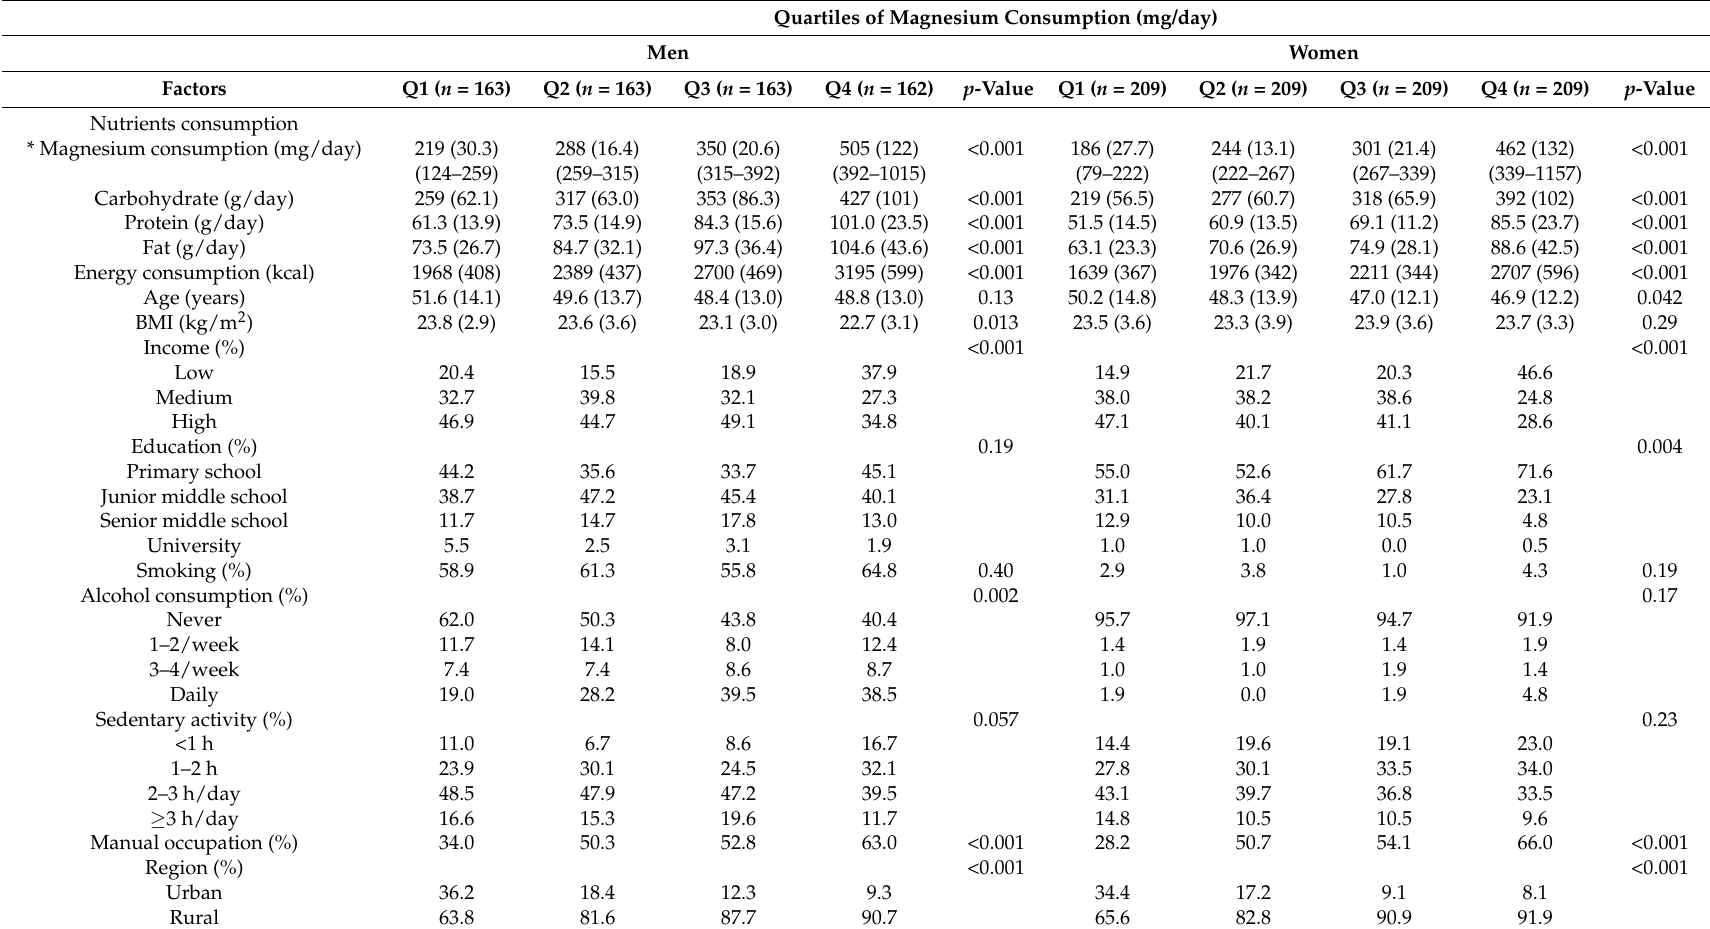
Table 1. Sex-specific characteristics of subjects by quartiles of magnesium consumption at baseline (2002) ( n = 1487) 1